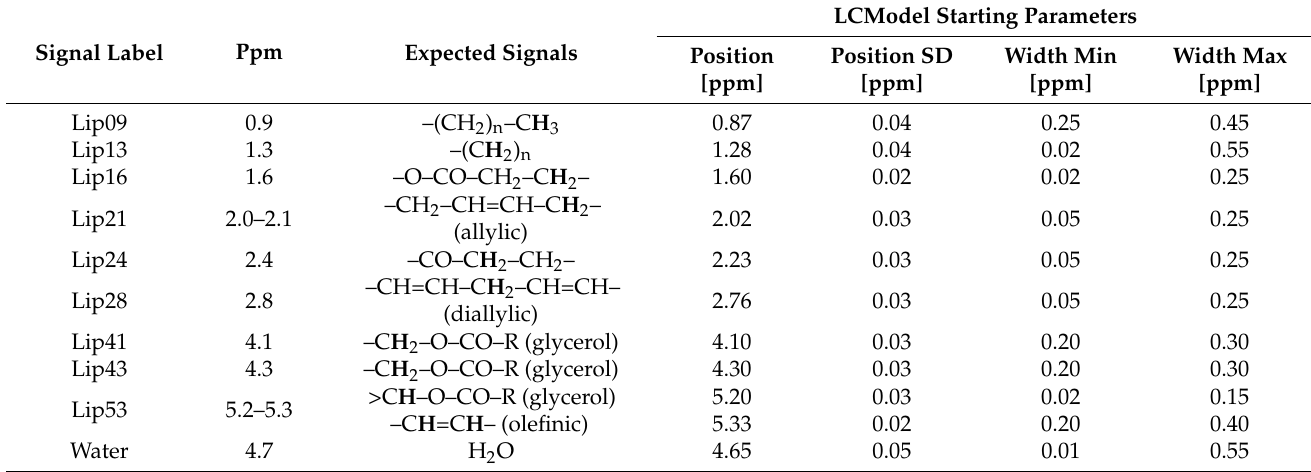
Table 1. Chemical shifts and corresponding structures in fatty acid chains in the human liver used for lipid profile calculation. LCModel [15] starting parameters for calculation of signal intensities in liver spectra are also shown.